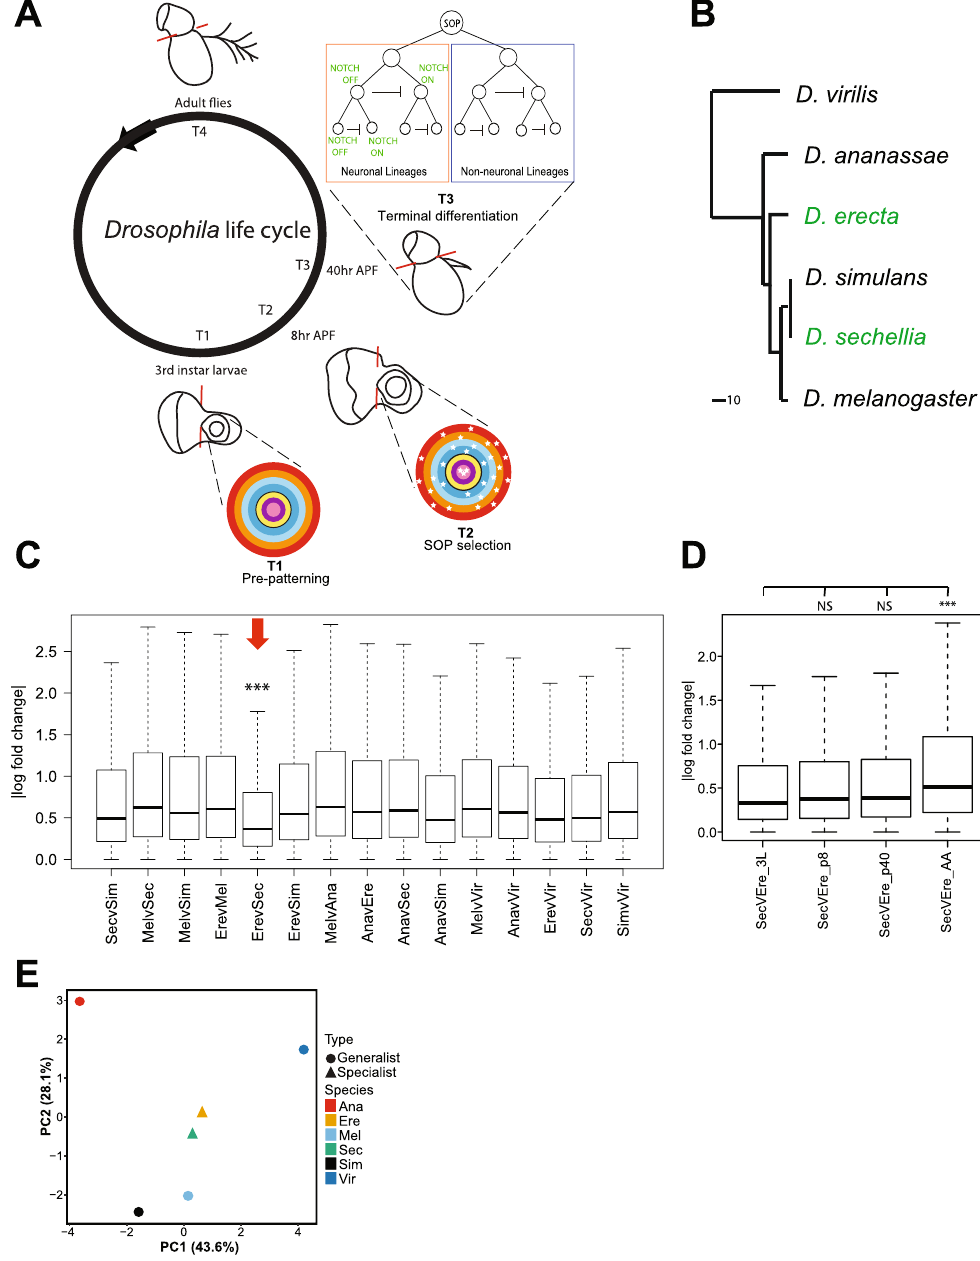
Figure 1. Broad parallelism in D . erecta and D . sechellia antennal transcriptomes during development. (A) Developmental time points during which samples were collected. The dotted red lines indicate where the antennal disc and the third antennal segment were isolated from surrounding tissue. Also shown are schematics of the developmental stages corresponding to each time point. (B) Phylogenetic tree of the six Drosophila species represented in our study 2,3 , with the positions of the specialist species D . sechellia and D . erecta highlighted in green; the scale bar represents time since divergence in millions of years (mya). (C) Pairwise interspecies comparisons of absolute log fold change (ALFC) values for all genes across all developmental time points, normalized for phylogenetic distance (see Methods). Asterisks indicate that D . sechellia versus D . erecta ALFC is significantly different compared to all other columns (ANOVA + Tukey’s HSD, n > 29,000, p < 0.001). (D) Comparisons of D . sechellia versus D . erecta ALFC for all genes across different developmental stages (ANOVA + Tukey’s HSD, n > 7000, NS = not significant, *** p < 0.001). (E) Principal component analysis (PCA) of DESeq-normalized transcript counts for transcription factors with known involvement in the development of the olfactory system (Table S1) during the 3 rd instar larval (3L) stage (n =